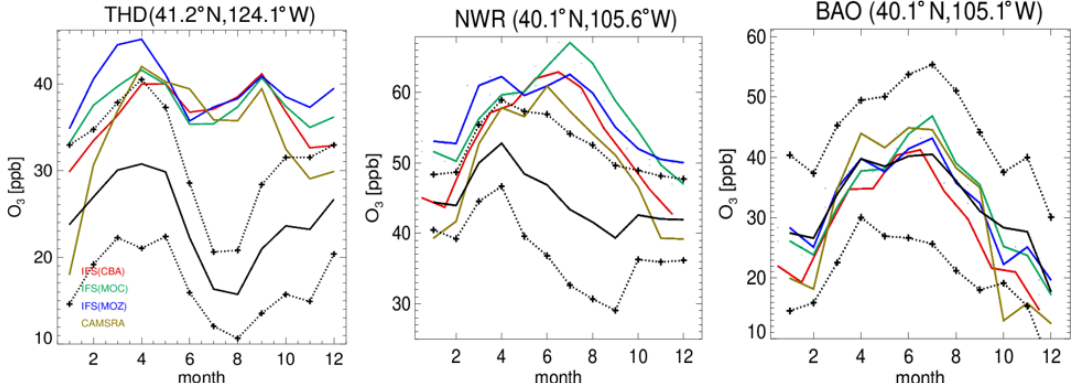
Figure 4. Comparisons of surface O 3 measurements for 2014 for the three GFDL stations situated in the US, namely THD, NWR and BAO. The observational means and the corresponding 1 σ variability are shown as the solid and dashed black lines, respectively.